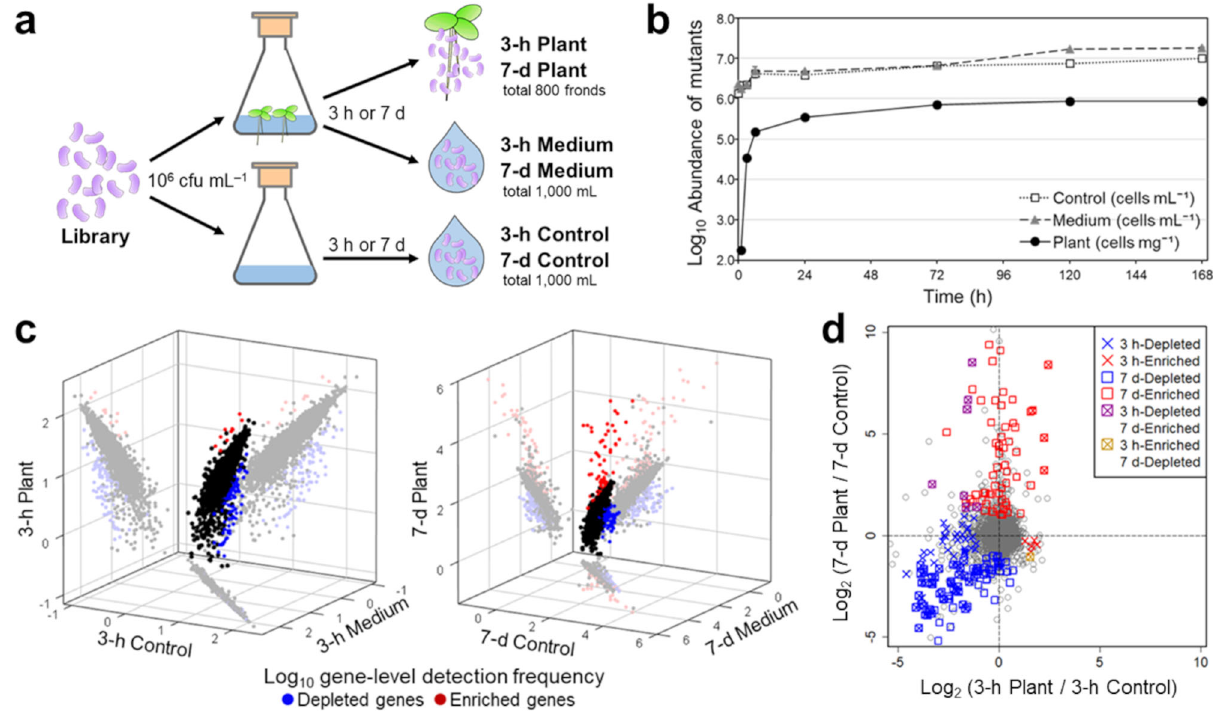
Fig. 1 Tn-seq screening identi fi ed colonization and fi tness determinants. a Schematic diagram of the screening experiments. The transposon mutant library of Aquitalea magnusonii H3rifR was inoculated to fl asks with and without duckweed, and the DNA of mutants was collected from three fractions after 3 h or 7 d. Samples were destructively obtained from four fl asks, and pooled before DNA extraction. b The abundance of mutant cells in the three fractions during the screening experiments. Error bars show standard deviation. c Detection frequency of genes in the three fractions after 3 h and 7 d. Log 10 gene- level detection frequencies were compared. Depleted and enriched genes were determined based on the effect size (fold change> 2) and statistical signi fi cance ( q < 0.05) among Plant and Control samples. Statistical test was performed by considering different mutants (insertion sites) of the same gene as replicates. d Comparison of the screening results of 3-h and 7-d experiments. Genes showed signi fi cant depletion or enrichment in the 3-h and 7-d experiments are denoted by crosses and squares,